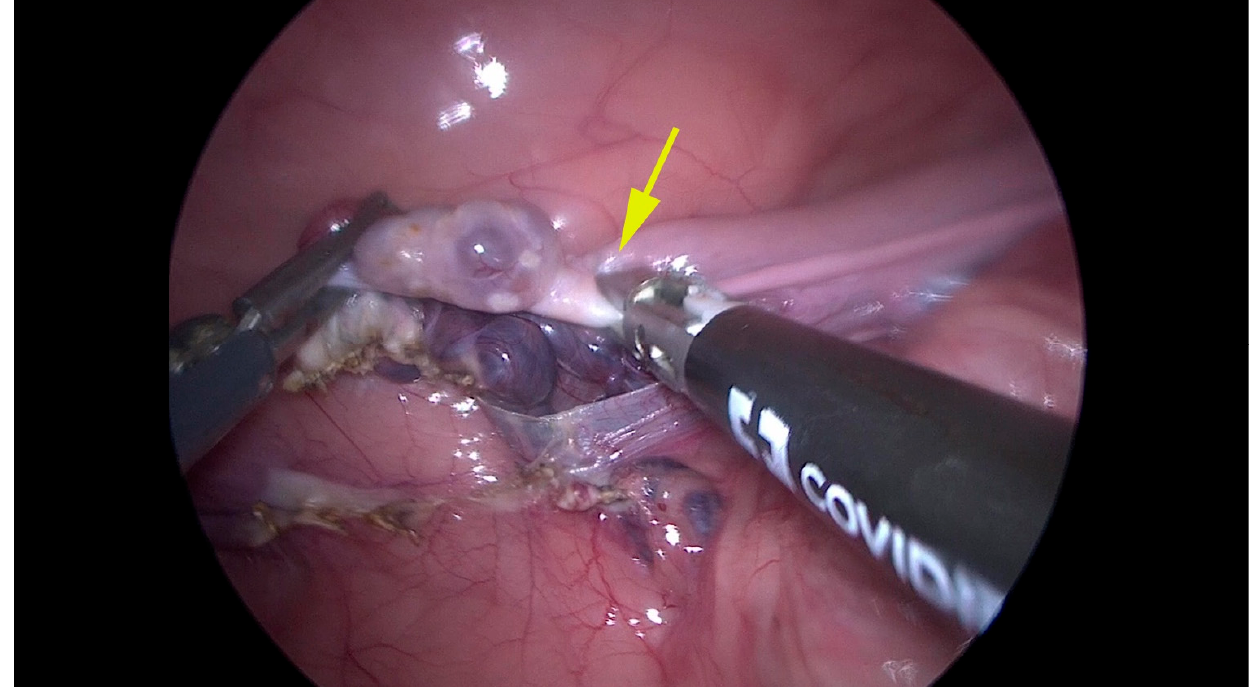
Figure 3. Representative image of the right ovariectomy performed by Atlas. Cranial is on the left. Yellow arrow shows that the branches clamped incompletely the cranial tip of the uterus incompletely, requiring several applications to be completed.